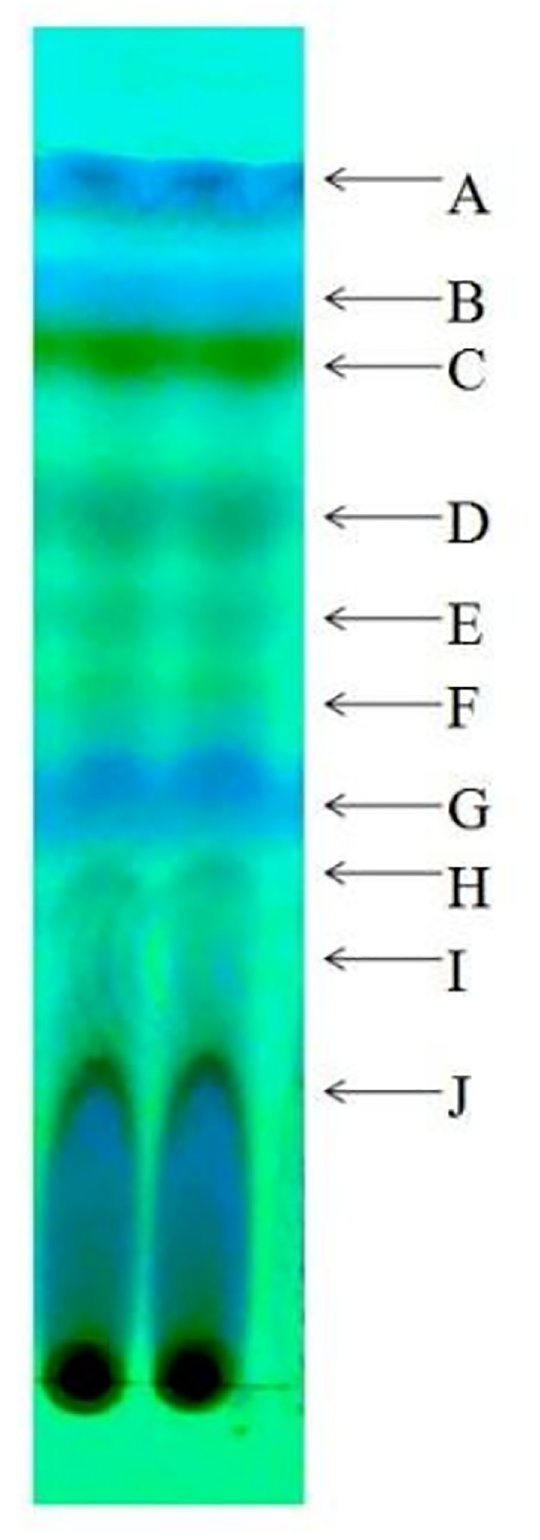
Fig 7. Thin layer chromatographic analysis of ethyl acetate fraction of AE1.